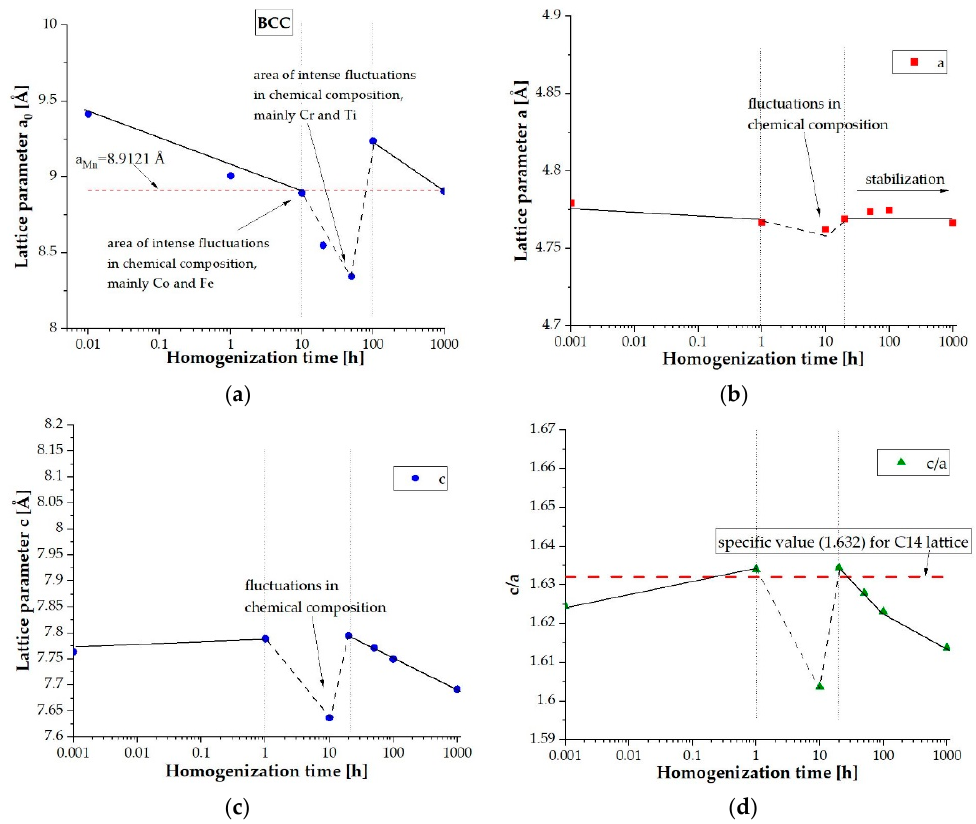
Figure 12. Changes in the parameters of the BCC ( a ) solid solution lattice and the Laves C14 ( b – d ) phase as a function of the homogenizing annealing